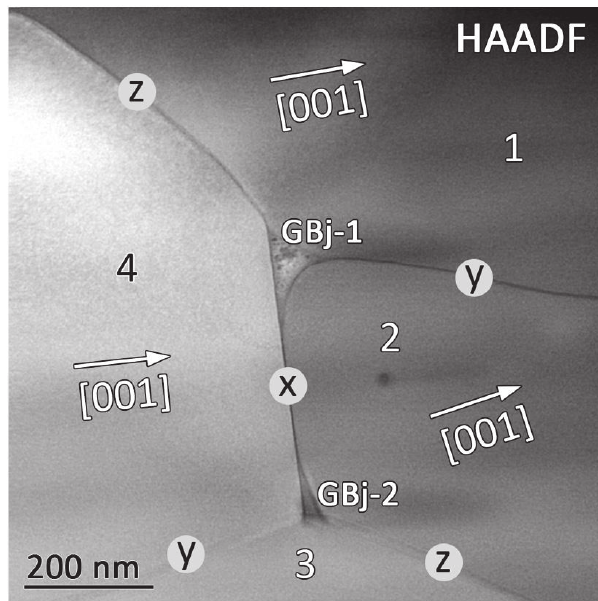
Figure 4: HAADF image of two GBjs surrounded by four (Pr,Nd) 2 (Fe,Co) 14 B grains ( [ 001] direction shown); 𝑥 -, 𝑦 -, and 𝑧 - GBs are